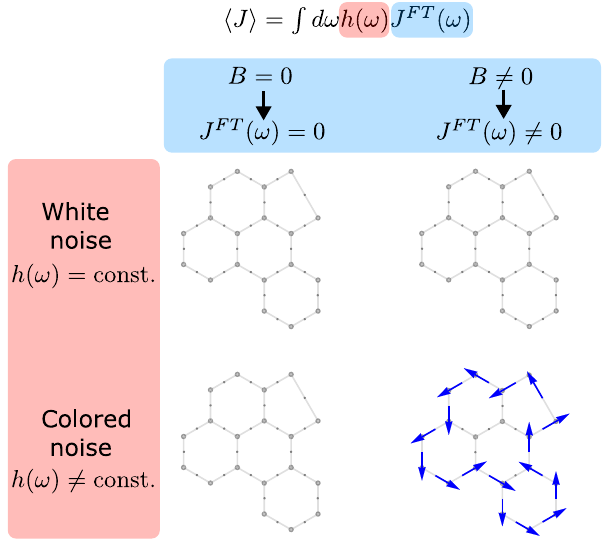
FIG. 2. Necessary ingredients for generating nonzero energy fluxes. Both the Lorentz-like force and colored noise are needed to generate nonzero fluxes. The role of the Lorentz-like force is to provide chiral Fourier modes ( J FT ð ω Þ ≠ 0 ). If B ¼ 0 , J FT ð ω Þ is zero everywhere. The role of colored noise is to provide weighted excitation h ð ω Þ ≠ const, which makes a nonvanishing averaged flux h J i possible. The numerical calculations were performed 1 with m , k , k , γ , T g a ¼